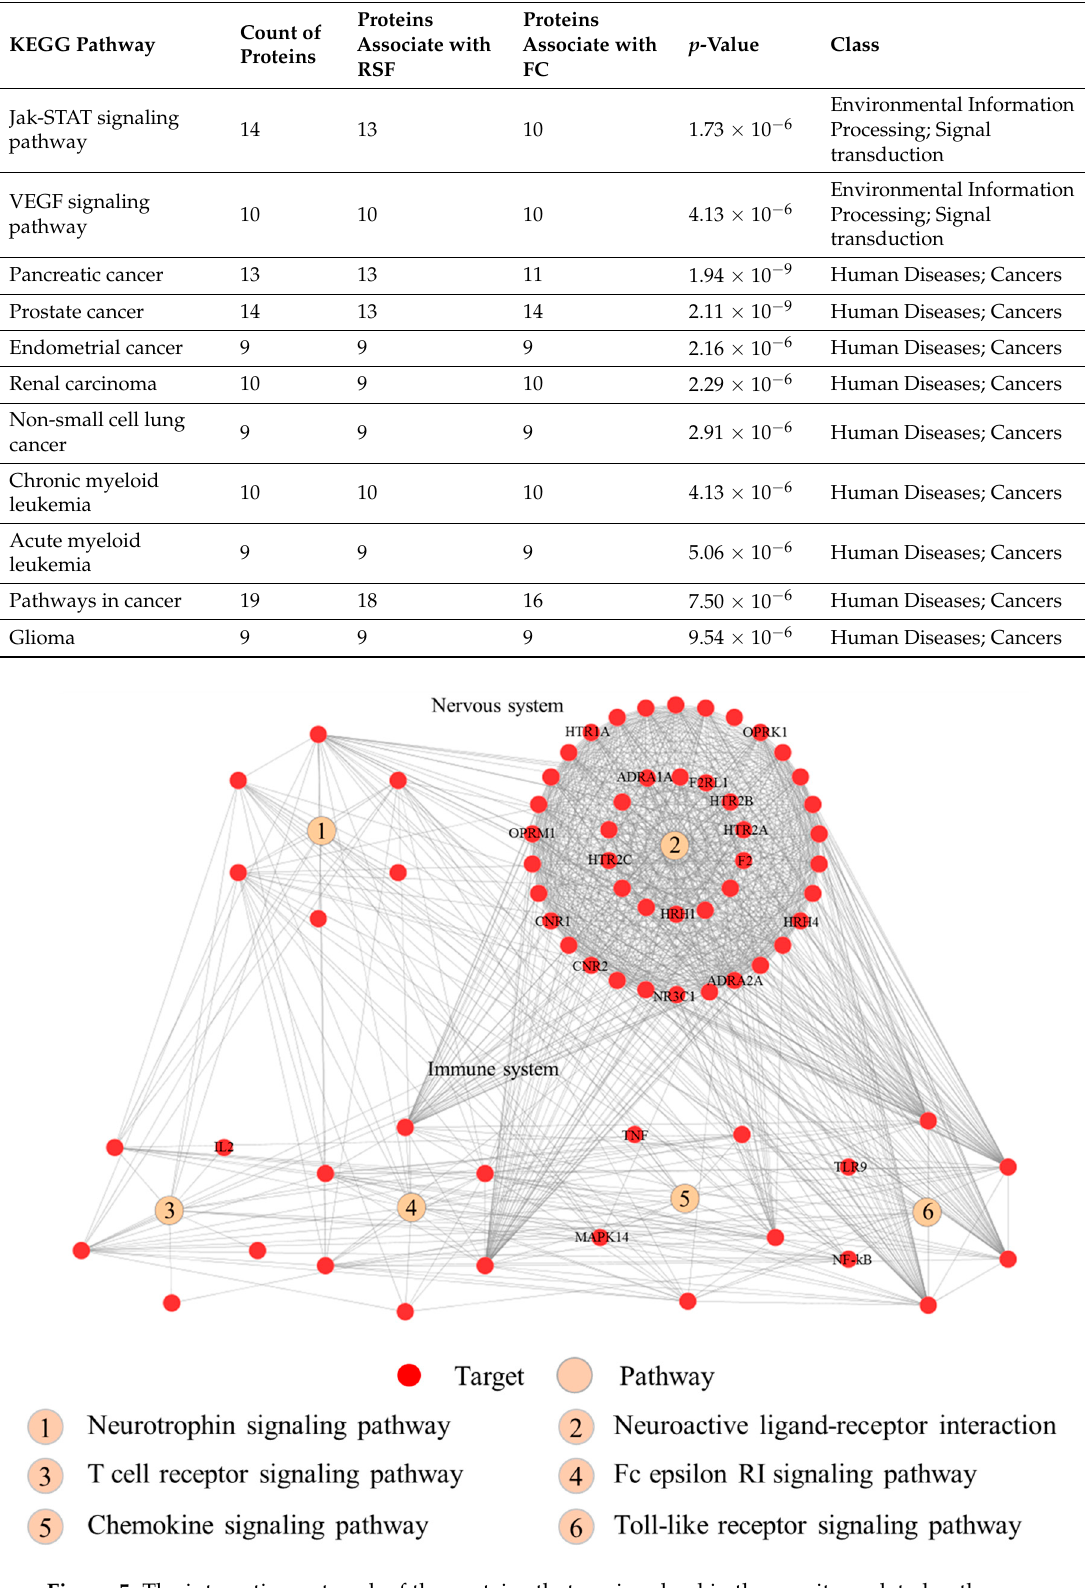
Figure 5. The interaction network of the proteins that are involved in the pruritus-related pathways.